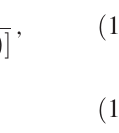
FIG. 5. (a) TTS opt versus the minimum spectral gap in QA, QAOA Δ , for many random w3R graph instances. 1000 random min instances are generated for each graph vertex size N . The maxi- 50 , 50, 40, 35, 30 for N ¼ 10 , mum cutoff p is taken to be p max ¼ 12, 14, 16, 18, respectively. The dashed line corresponds to the prediction of TTS ∝ 1 = Δ 2 in the adiabatic regime using the min versus TTS opt for each Landau-Zener formula [39]. (b) TTS opt QAOA QA random graph instance. The dashed line indicates when the two are equal. The (Pearson ’ s) correlation coefficient between the two is ρ ½ ln ð TTS opt Þ ; ln ð TTS opt Þ(cid:2) ≈ 0 . 91 QAOA QA